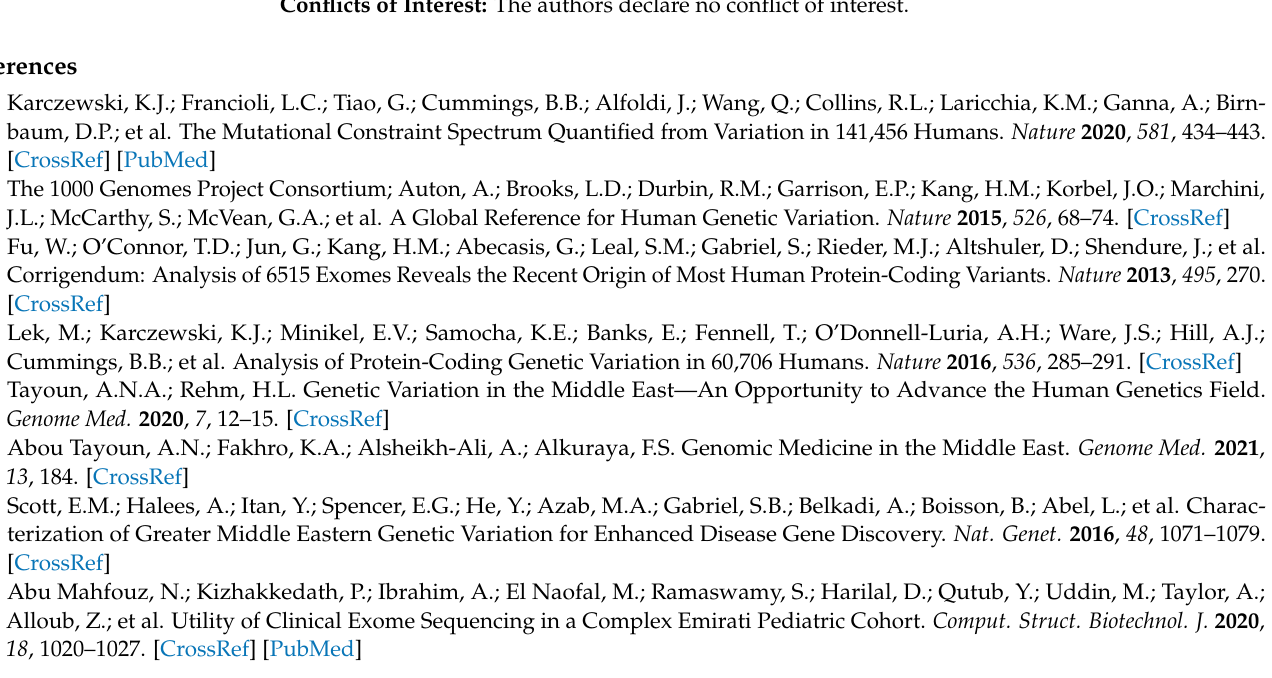
Table S3: Unique high confidence